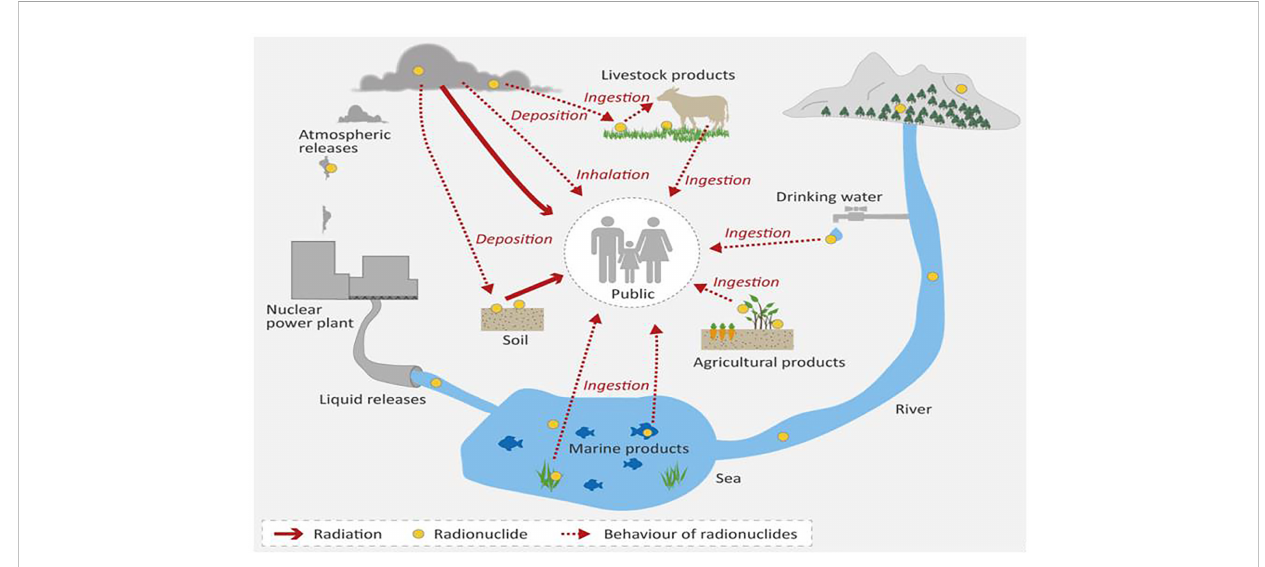
FIGURE 1 Exposure pathways of Japan ’ s Fukushima nuclear wastewater. Source: The Fukushima Daiichi Accident (IAEA, 2015)